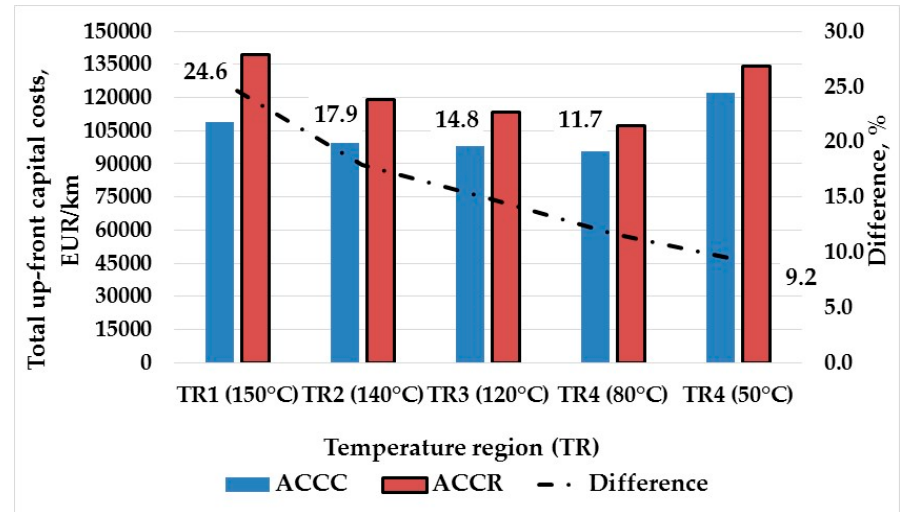
Figure 12. Total up-front capital costs for construction of a new transmission line (TL) for “OHL No.1” case.